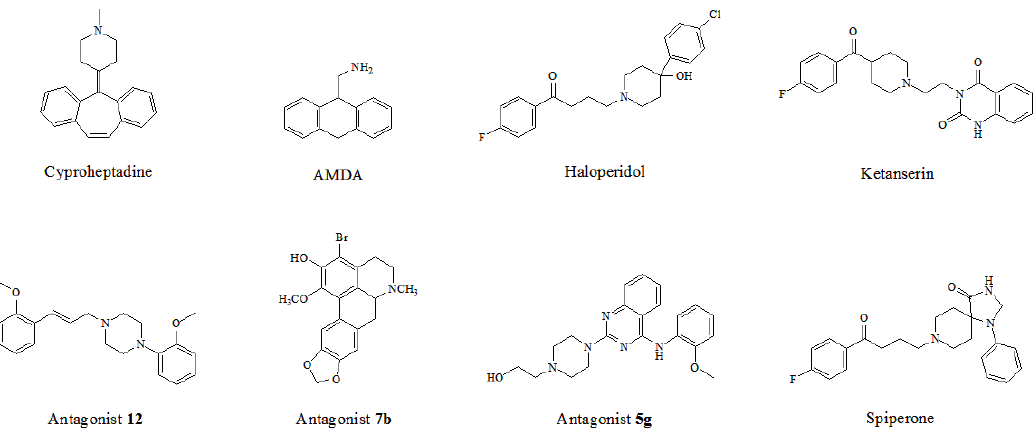
Figure 10. Eight known 5-HT 2A antagonists binding in the 5-HT 2A receptor docking